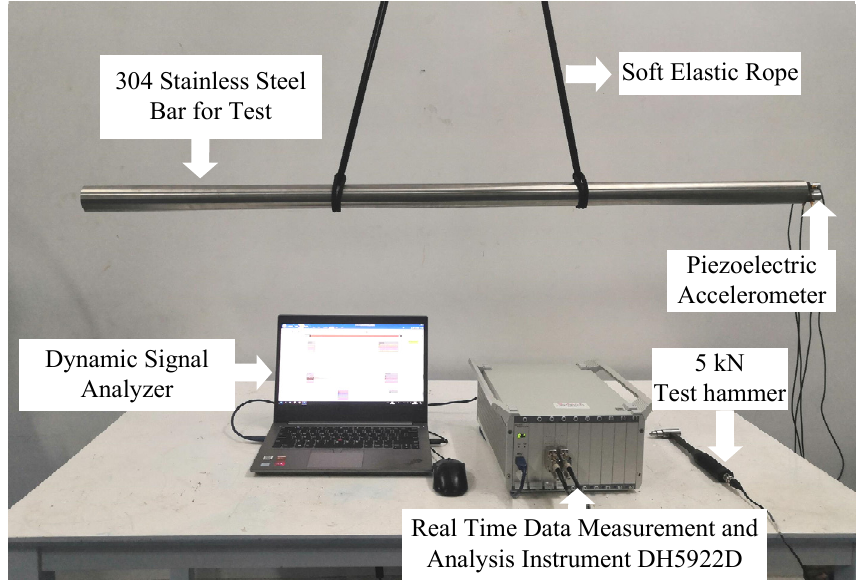
Figure 6. Experimental device for extracting the damping ratio of a stainless steel 304 bar sample.